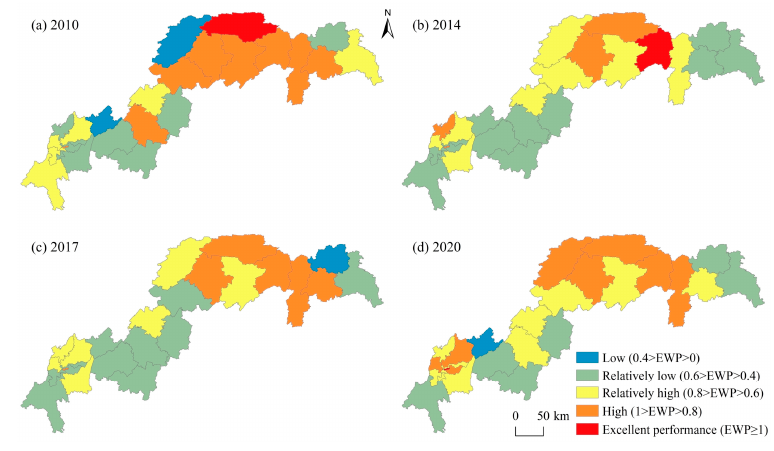
Figure 6. Spatial Distribution of EWP in the TGRA.